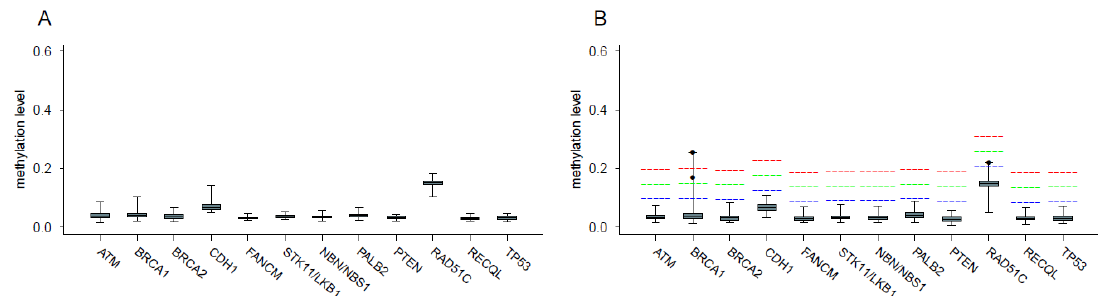
Figure 2. distribution of the mean methylation levels at each promoter in blood samples from the 60 controls (panel A ) and 154 patients (panel B ); the red, green and blue dashed lines indicate the thresholds used for the identification of hypermethylated cases obtained by adding the prefixed value of 0.15, 0.1 and 0.05 respectively to the one-sided 95% bootstrap confidence interval of the controls’ mean; the dots indicate mean methylation level of the three hypermethylated cases.